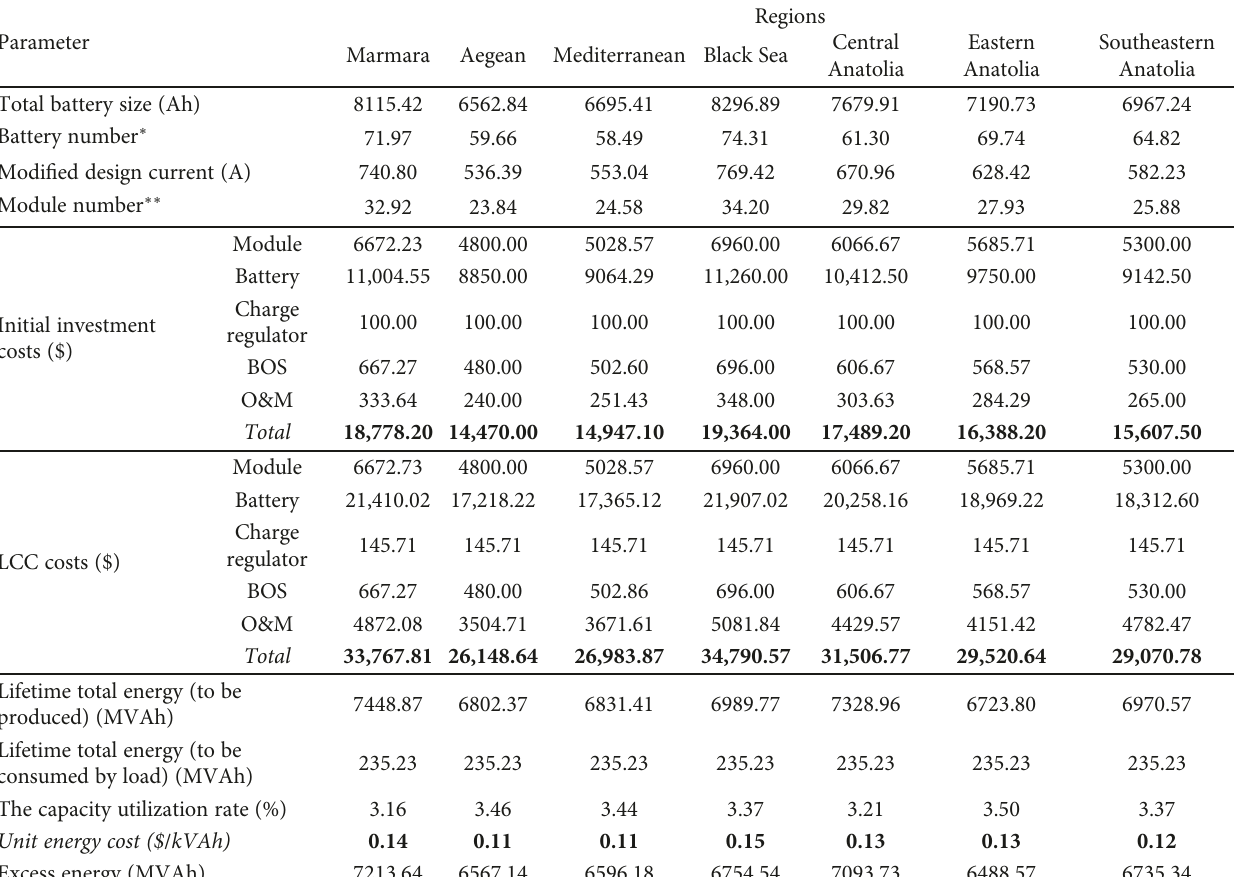
Table 3: Calculations for the all-year (8760 hours) scenario.